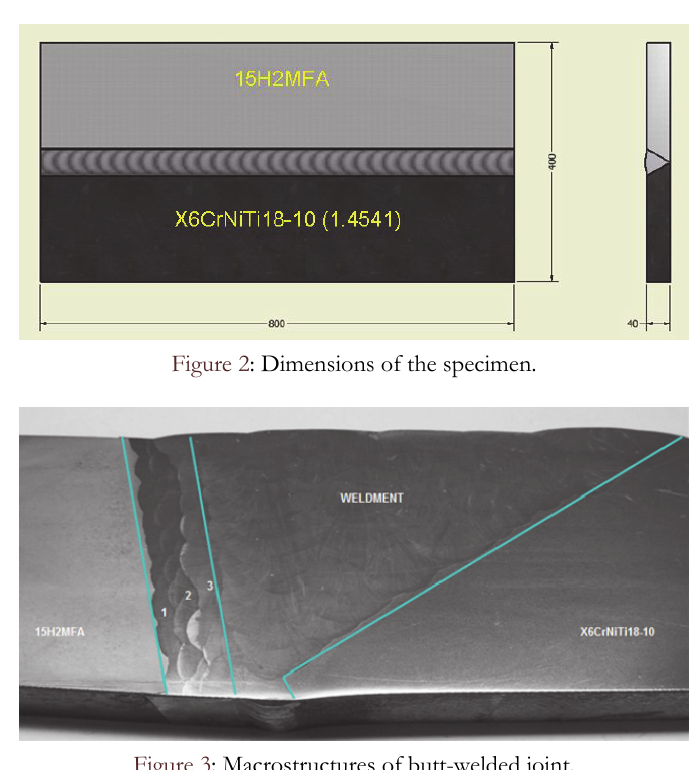
Figure 3: Macrostructures of butt-welded